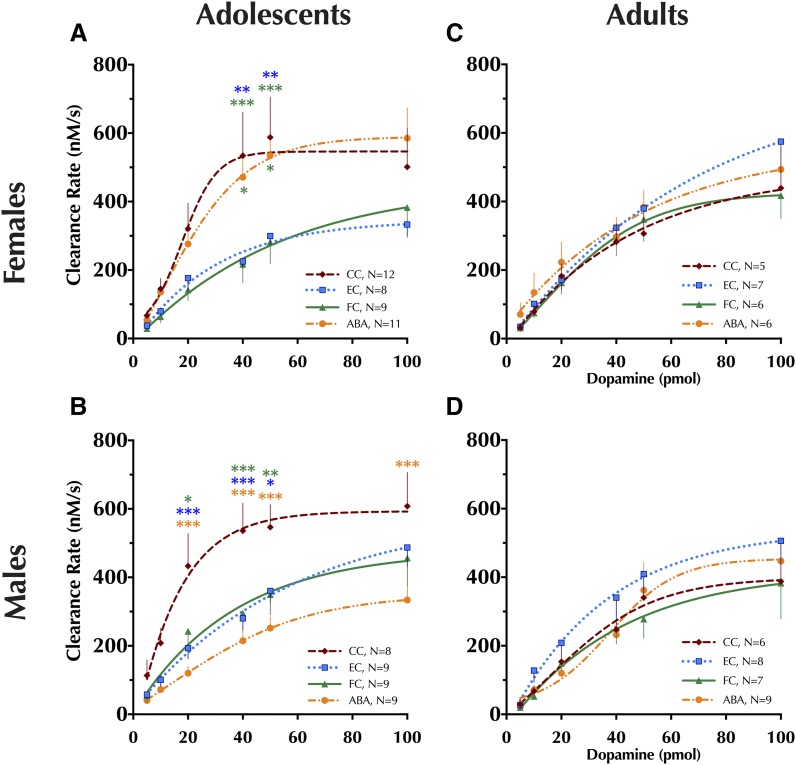
Striatal dopamine clearance measured using in vivo high-speed chronoamperometry. Clearance rate of dopamine in the striatum of adolescent (A) female and (B) male rats and adult (C) female and (D) male rats is shown for increasing amounts of exogenously infused dopamine. Four-parameter logistic regressions with baseline constrained at 0 were used to generate curve fits. Data analyzed within each age and sex group using a repeated-measures (pmol DA × condition) ANOVA with Tukey-Kramer’s post-hoc tests where appropriate. Data are graphed as mean ± S.E.M. *P < 0.05; **P < 0.01; ***P < 0.001 vs. same-sex condition, indicated by color of asterisk(s), within the same picomole amount. Number of animals is indicated in respective legends: cage control (CC), exercise control (EC), food restricted control (FC), activity-based anorexia (ABA).